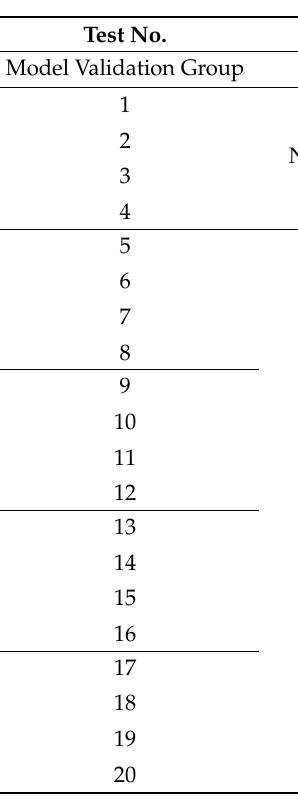
Table 3. Simulation